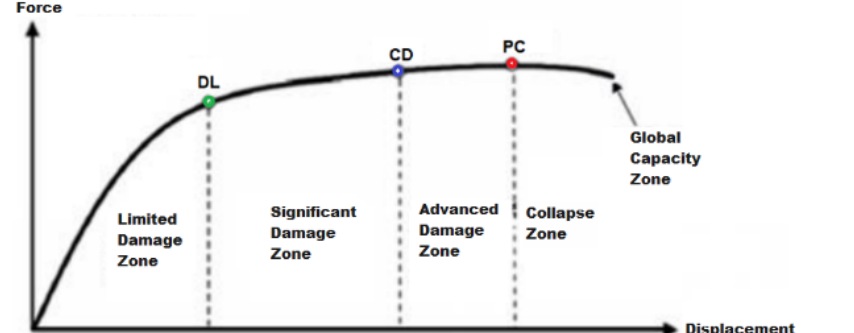
Figure 14. Section damage limits and damage zones [64].